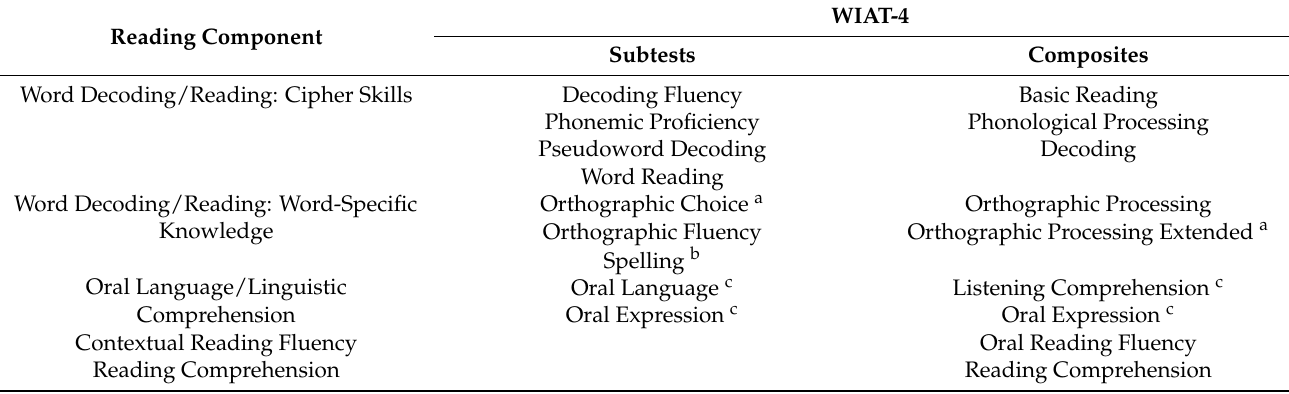
Table 3. WIAT-4 Subtest and Composite Scores Aligned with the Simple View of Reading and its